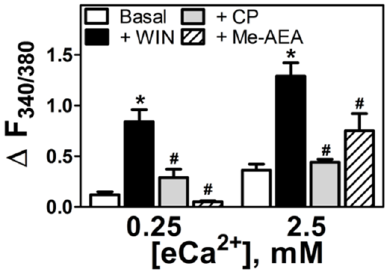
Figure 3. Aminoalkylindole-specific increase in [Ca 2+ ] i in N18TG2 cells. Increases in [Ca 2+ ] i in con- ditions of low (0.25 mM) and high (2.5 mM) eCa 2+ in the presence of WIN55212-2 5 μ M (+WIN, n = 7), the bicyclic mimetic of THC CP55940 5 μ M (+CP, n = 4), or the arachidonoylethanolamine